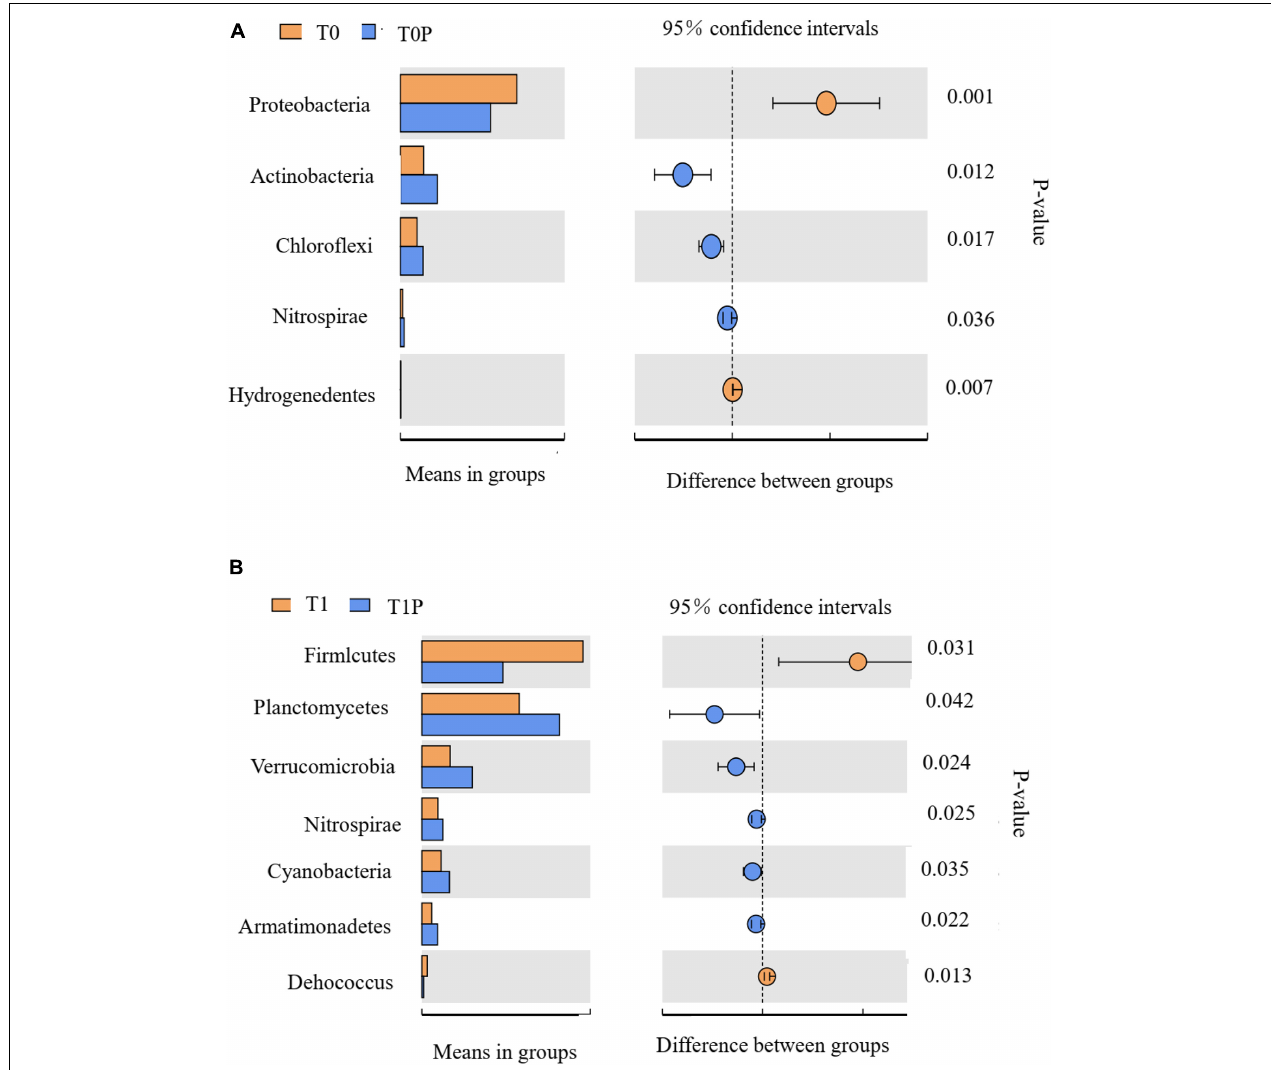
FIGURE 7 | Bacterial phyla with relative abundance significantly different in the comparison between (A) control soil with no additions (T0) and soil with only phosphate-solubilizing bacteria (PSB) (T0P) and between (B) soil with only rock phosphate (RP) amendment (T1) and soil with both RP and PSB (T1P). Significant differences in relative abundance were determined by t -tests. On the left: the abundance of taxa in each group, with each horizontal bar representing the mean value. On the right: the intergroup difference confidence level and the P -value for the significant difference in